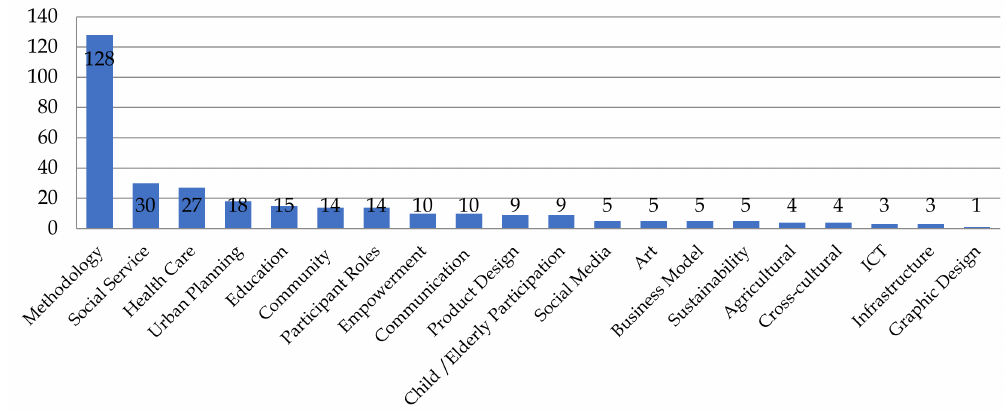
Table4. Thedistributionofthetop10keywordsrelatedtoparticipatorydesign,co-design,andco-creation.